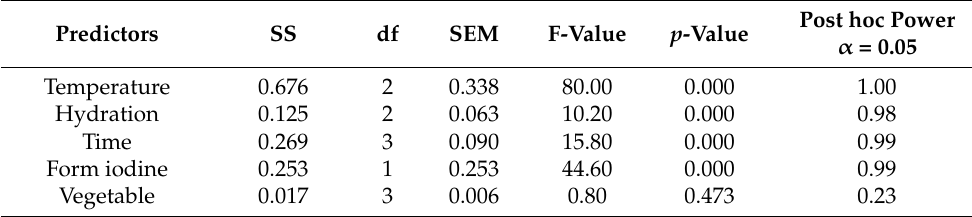
Table 1. Statistical significance of predictors of covariance models for changes in iodine content in selected iodine carriers during